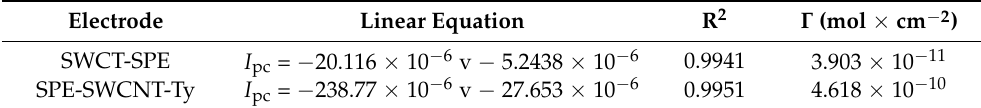
Table 2. Linear equation ( I pc vs. v), R 2 and Γ for the two electrodes used in the analysis. Electrode